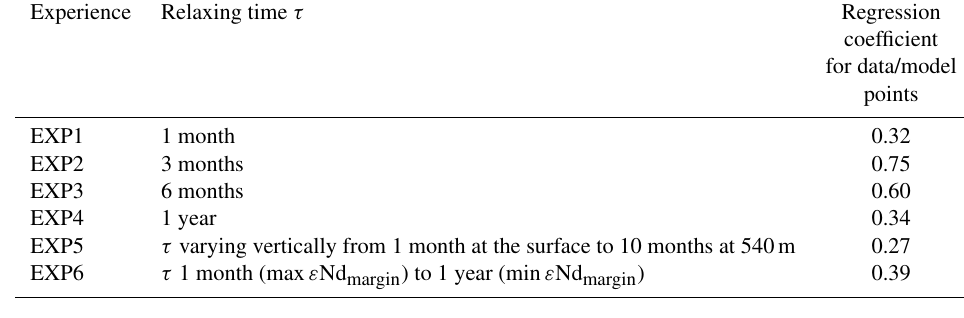
Table 3. Summary of the main characteristics for each experience.